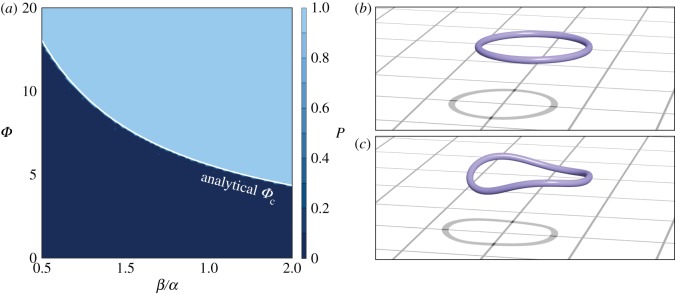
Mitchell buckling instability. (a) Probability P of observing an instability event as a function of the total twist Φ and the ratio between bending and twist rigidities β/α. The corresponding analytical solution is overlaid as reference (white line). The probability P is determined by performing 10 simulations for each pair of parameters (Φ,β/α). Each simulation is initially perturbed by applying to every discretization node a small random force sampled from a uniform distribution, such that ∥FR∥∼U(0,10−3) N. The occurrence of an instability is detected whenever the rod translational energy ET>Eth with Eth=10−4 J. (b–c) Visualization of a Mitchell bucking instability event for Φ=10 and β/α=2. Settings: rod’s mass mr=1 kg, length L= 1 m, bending stiffness α=1 Nm2, shear/stretch matrix S= 105×1 N, bend/twist matrix B=diag(α,α,β) Nm2, radius r= 0.01L m, discretization elements n=50 m−1, timestep δt= 10−5 s, simulation time Tsim=2 s, dissipation constant γ=0.